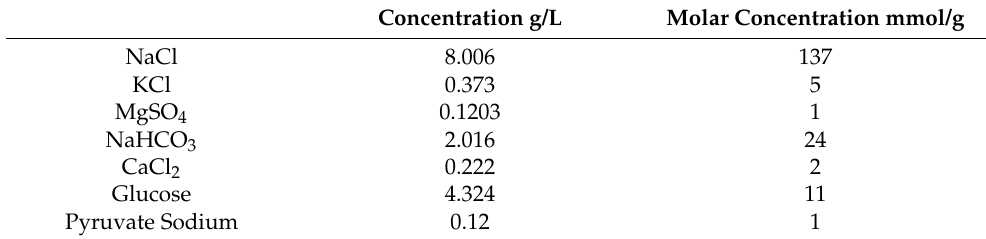
Table 3. Composition content table of muscle tissue nutrient